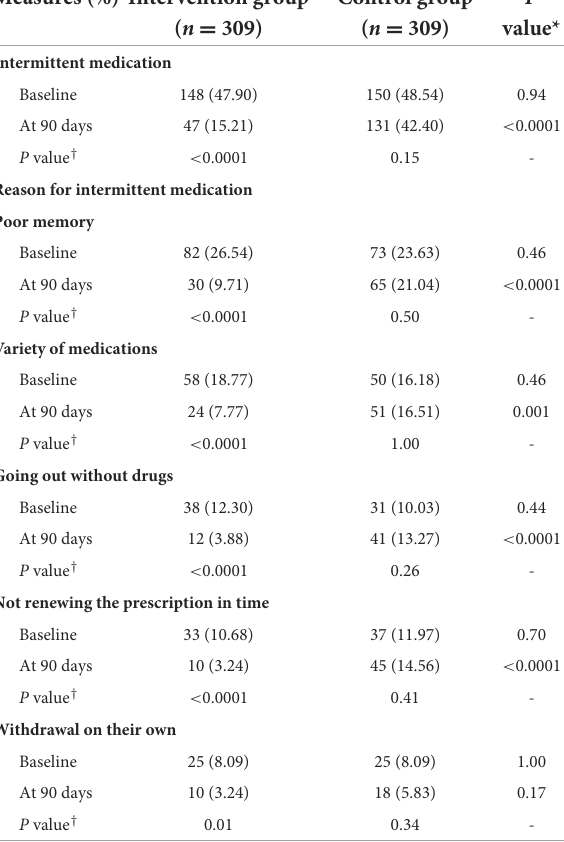
TABLE 4 Intermittent medication and its reasons for elderly patients with multimorbidity.